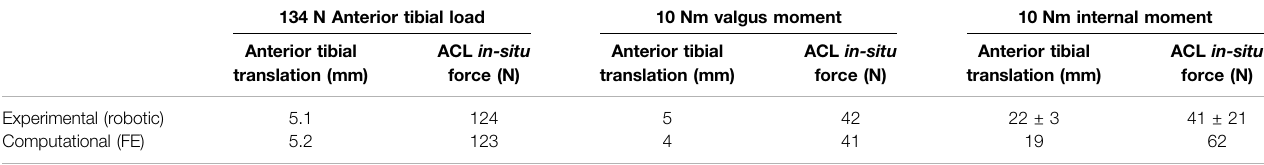
TABLE 2 | Anterior tibial translation, valgus rotation and internal rotation of tibial, and ACL in-situ force obtained from robotic testing and FE model under the loading conditions 1) 134 N anterior tibial load; 2) 10 Nm valgus moment; 3) 10 Nm internal moment at a joint fl exion angle of 30 ° (Wang et al., 2020b). 134 N Anterior tibial